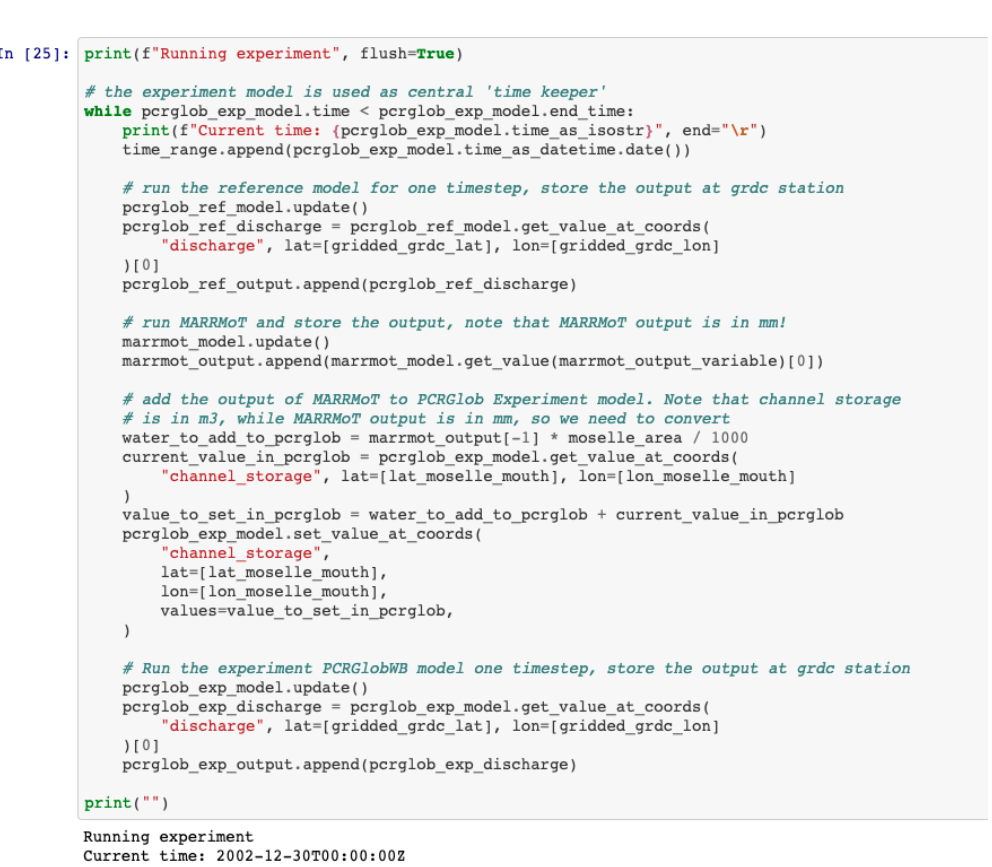
Figure 10. The central loop of the experiment presented in Sect. 4.3. Within the loop three models are run: MARRMoT for the Moselle sub-basin and two instances of PCR-GlobWB 2.0. The first, called “reference”, runs the entire Rhine basin without alteration. The second, called “experiment”, runs the Rhine basin with the Moselle subcatchment cut out (by altering the landmask file). At every time step the discharge calculated by MARRMoT for the Moselle is added to the “channel storage” variable of PCR-GlobWB 2.0 at the mouth where the Moselle enters the Rhine (at Koblenz). This code snippet shows how the eWaterCycle platform supports model coupling without having to interfere with the code of the models being